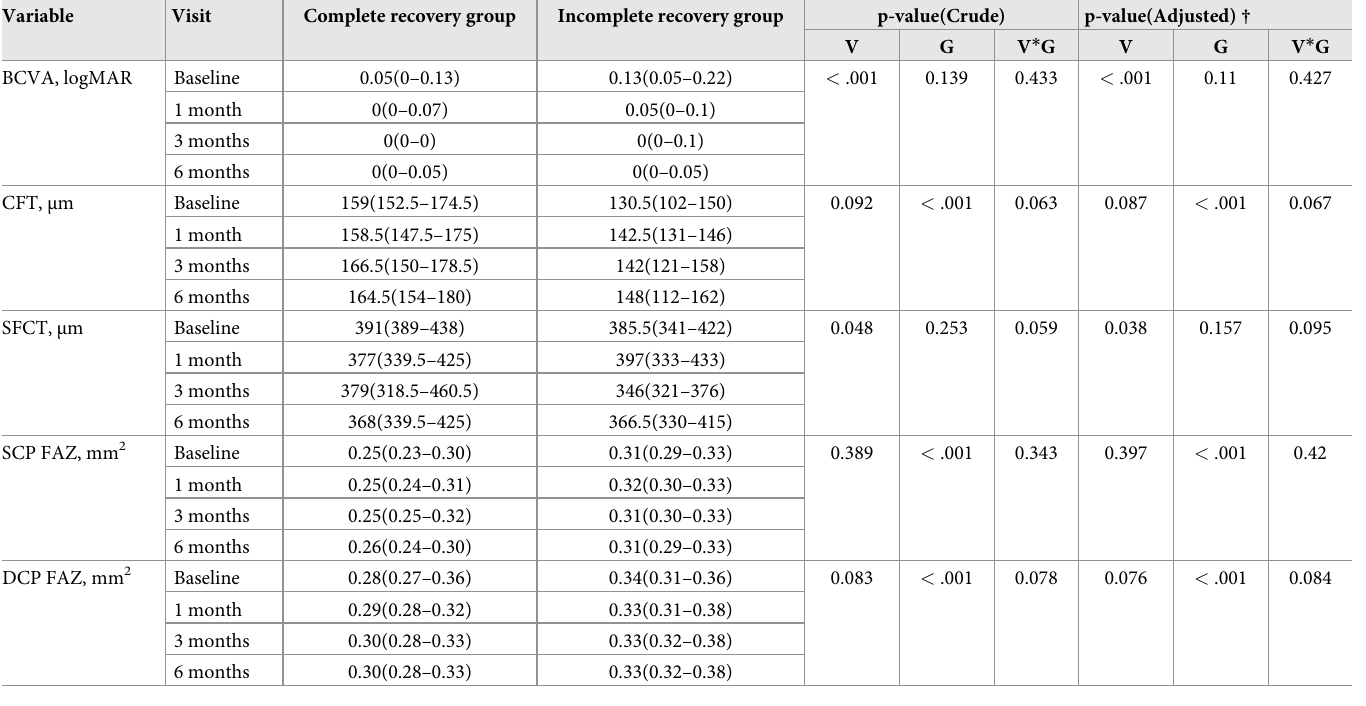
Table 2. Comparison of sequential characteristics by groups and by the